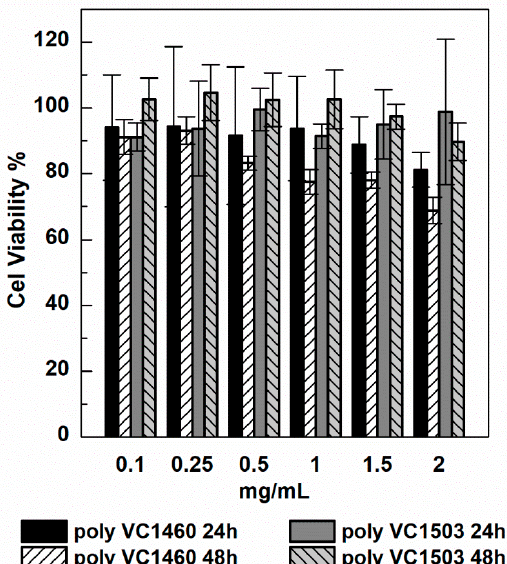
Figure 20. Cell viability % (MTS assay) of poly-4,6-MOEG-9-TM- BF3k (poly-VC1460) and poly-4’,6- MOEG-9-TM- BF3k (poly-VC1503) on human colon cancer HCT116 cells after 24 h and 48 h of incubation. Differences between tested groups are not statistically significant ( p >